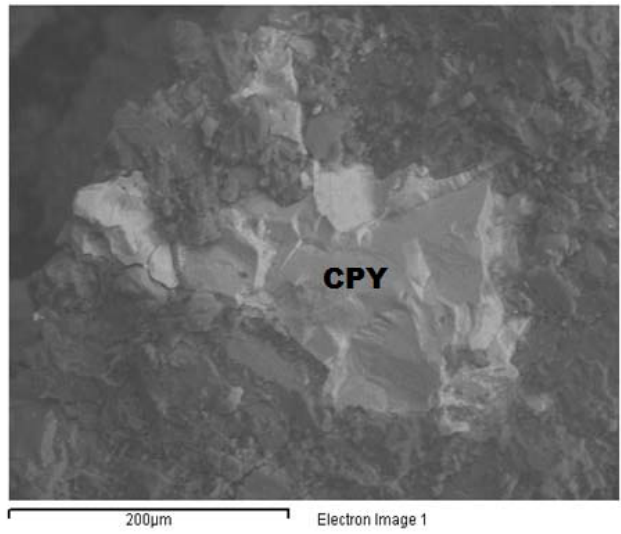
Figure 2. SEM image of chalcopyrite (CPY) in the feed ore sample showing chalcopyrite inclusion among gangue minerals.